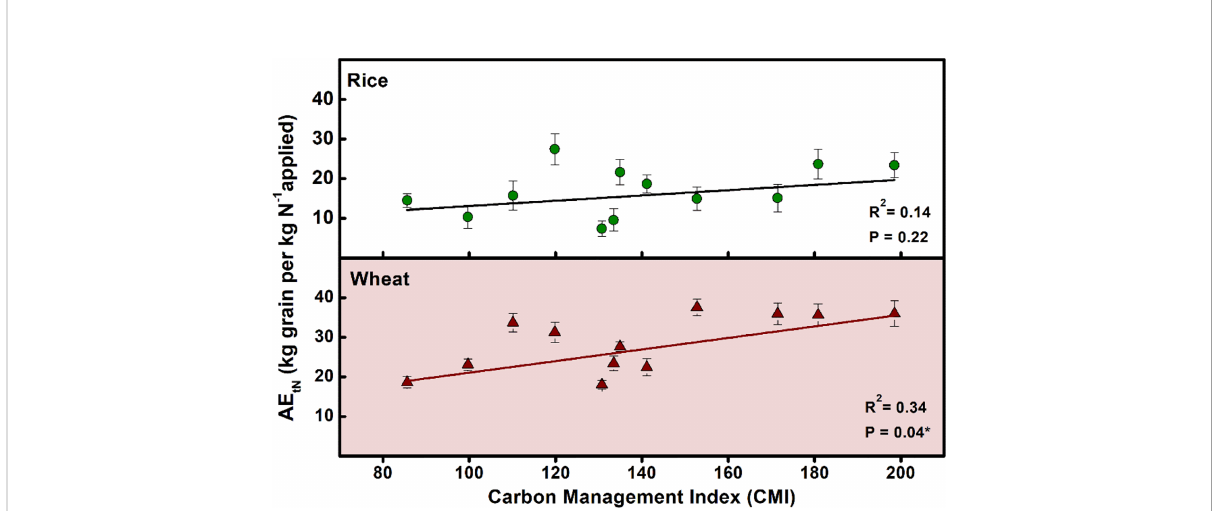
FIGURE 10 Relations of soil organic carbon (OC) and carbon management index (CMI) with nitrogen use ef fi ciency under rice-wheat systems. Error bars denote ± 1SD. Refer to Figure 2 for a description of